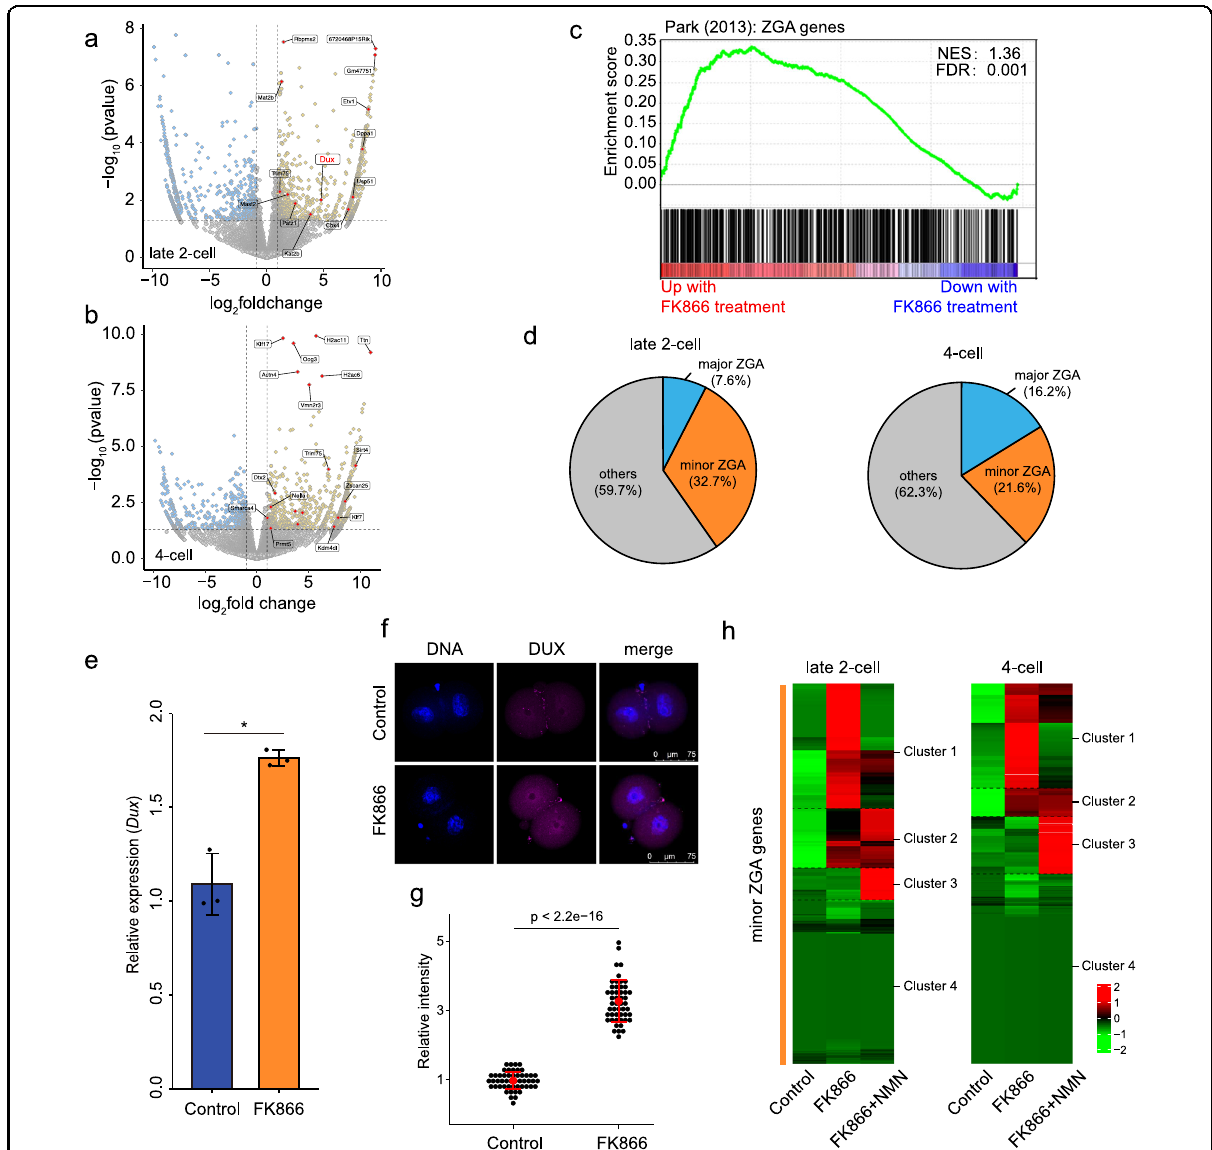
Fig. 4 NAD + depletion disturbs minor ZGA in early mouse embryos. RNA-seq analysis of control and FK866-treated a late 2-cell and b 4-cell mouse embryos. Volcano plots show gene expression changes. Yellow and blue dots indicate upregulated (fold change > 1) and downregulated (fold change < − 1) genes with P < 0.05. c Gene set enrichment analysis (GSEA) of ZGA genes showed preferential upregulation in FK866-treated late 2-cell embryos. d Pie chart showing the fraction of minor and major ZGA genes upregulated in late 2-cell and 4-cell embryos. e Results of quantitative polymerase chain reaction (qPCR) showing Dux upregulation in FK866-treated late 2-cell embryos. Data are means ± SEM from three independent experiments. f Representative confocal images of control and FK866-treated embryos stained with Dux antibody. Scale bars, 75 µm. g Quanti fi cation of DUX fl uorescence intensity in control and FK866-treated embryos. Each dot represents a single nucleus. h Heatmaps show that minor ZGA genes were upregulated between control and FK866-treated embryos, which was rescued by NMN supplementation. NMN recovered the overexpression of 62% and 72.2% minor ZGA genes at late 2-cell and 4-cell stages, respectively. Mean values of two biological replicates were scaled and are represented as Z